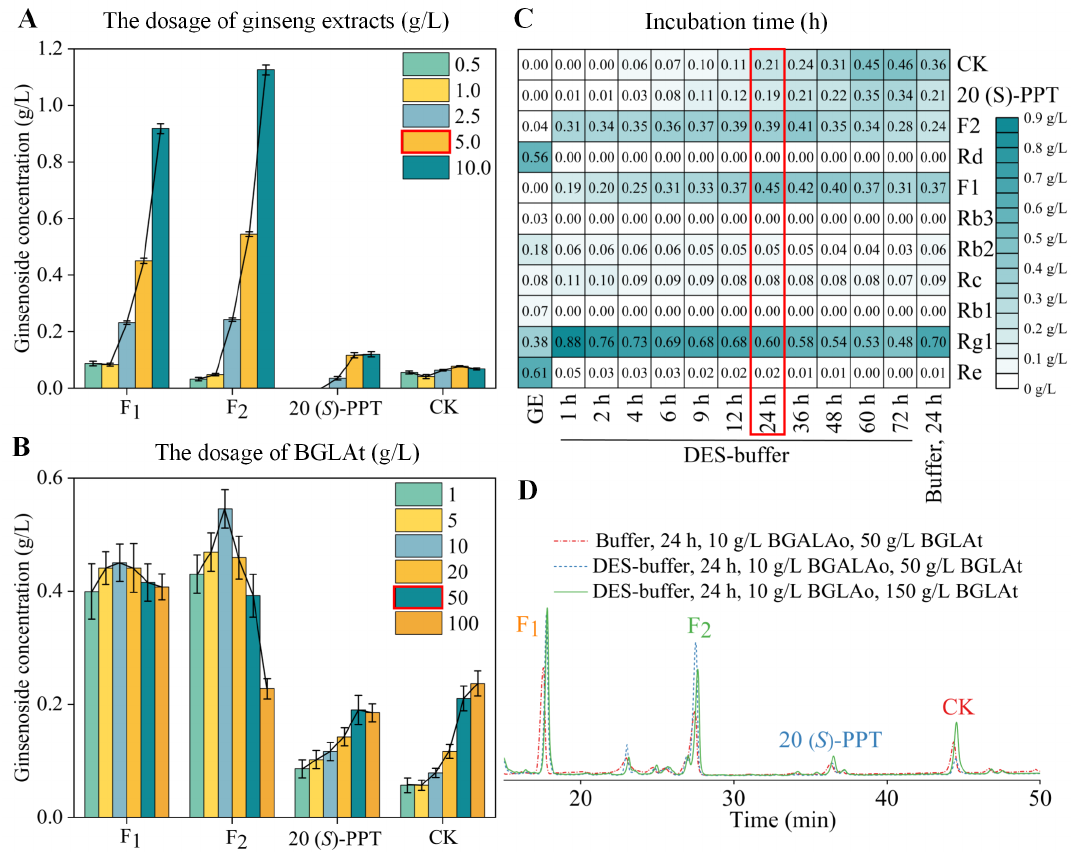
Figure 3. Process optimization for De-g production. ( A ) Substrate inhibition on De-g yield with different dosages of GE (0.5, 1.0, 2.5, 5.0, and 10.0 g/L) in DES-buffer. ( B ) Enzyme inhibition on De-g yield with different dosages of BGLAt (1, 5, 10, 20, 50, and 100 g/L) in DES-buffer. Error bars represent the corresponding standard deviation of three independent experiments ( n = 3) ( A , B ). ( C ) De-g yield under the process (sampled at 1, 2, 4, 6, 9, 12, 24, 36, 48, 60, and 72 h), compared with GE and the samples in buffer for 24 h (buffer, 24 h). ( D ) HPLC analysis of De-g changes in samples containing 50 g/L BGLAt incubated in buffer, containing 50 g/L BGLAt incubated in 10 wt % DES-buffer, containing 150 g/L BGLAt incubated in 10 wt % DES-buffer. The remaining conditions for the preparation of samples were the same, containing 5 g/L GE and 10 g/L of BGALAo at 50 °C for 24 h reaction. De-g contains F 1 , F 2 , 20 ( S )-PPT, and CK ( A – D ). DES-buffer means that the buffer (citric acid buffer, 20 mM, pH 6.0) contains 10 wt % of DES (Bet: EG, 1:2) ( A – D ).